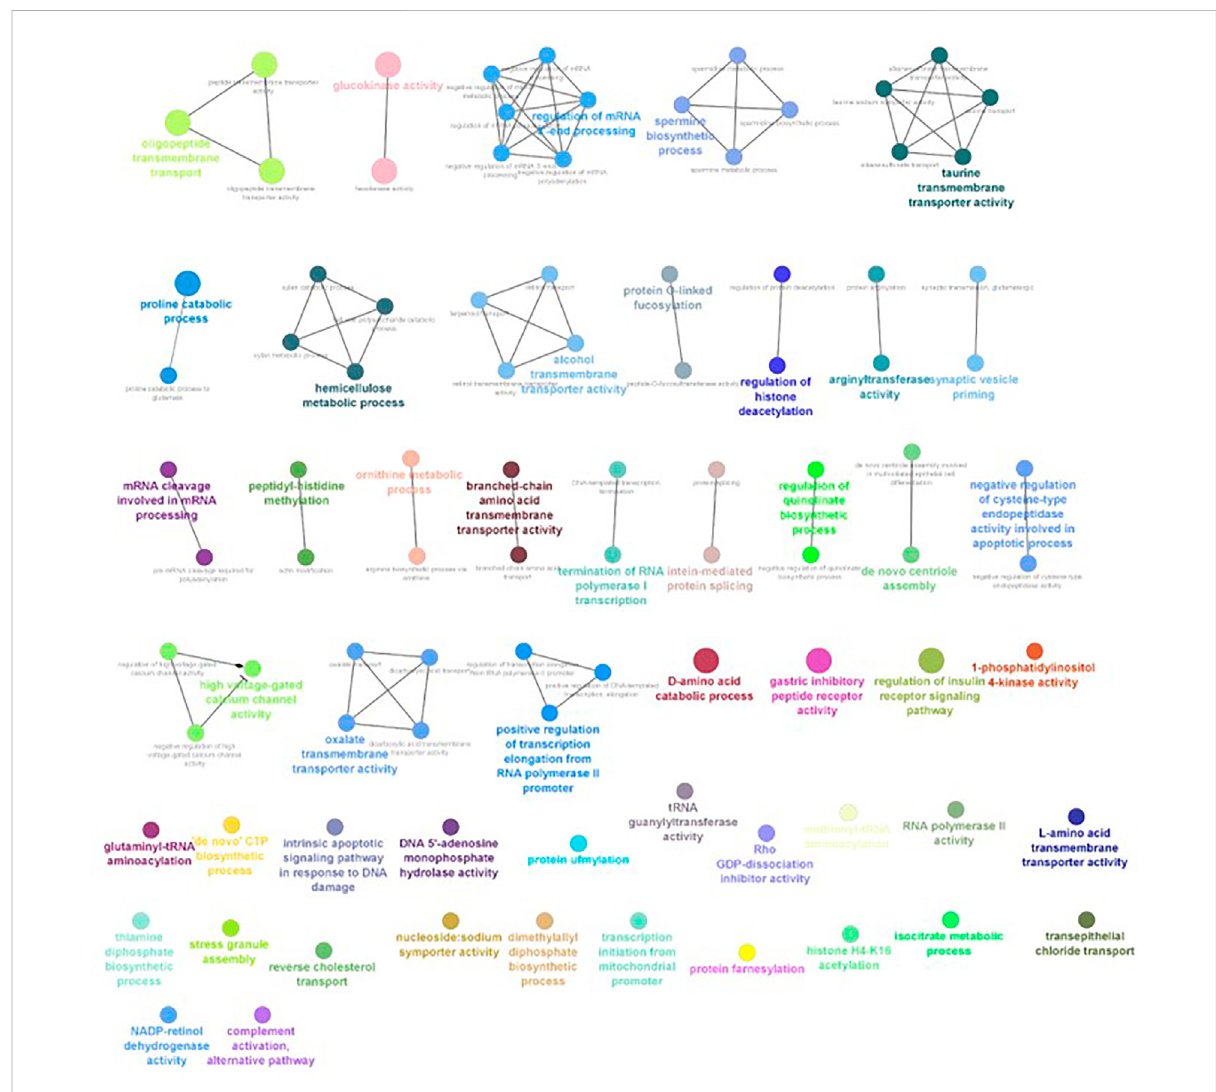
FIGURE 8 ClueGO enrichment network of the 6-ppt salinity-challenged treatment group DEGs of L. rohita , with the p -value cut-off < 0.05, the interactions of the GO terms network determined by functional nodes, and edges shared between differentially expressed genes with a kappa score of 0.4. The generated network has 148 nodes and 217 edges. Each node represents an individual biological process, and the color refers to the GO group. Intotal, 49GO groups arepresent inthenetwork,and edgesrepresent therelationshipbetween theGO termsbased onthesimilarityof their associated genes. The bold font indicates an important GO term that de fi nes the name of the biological process of each